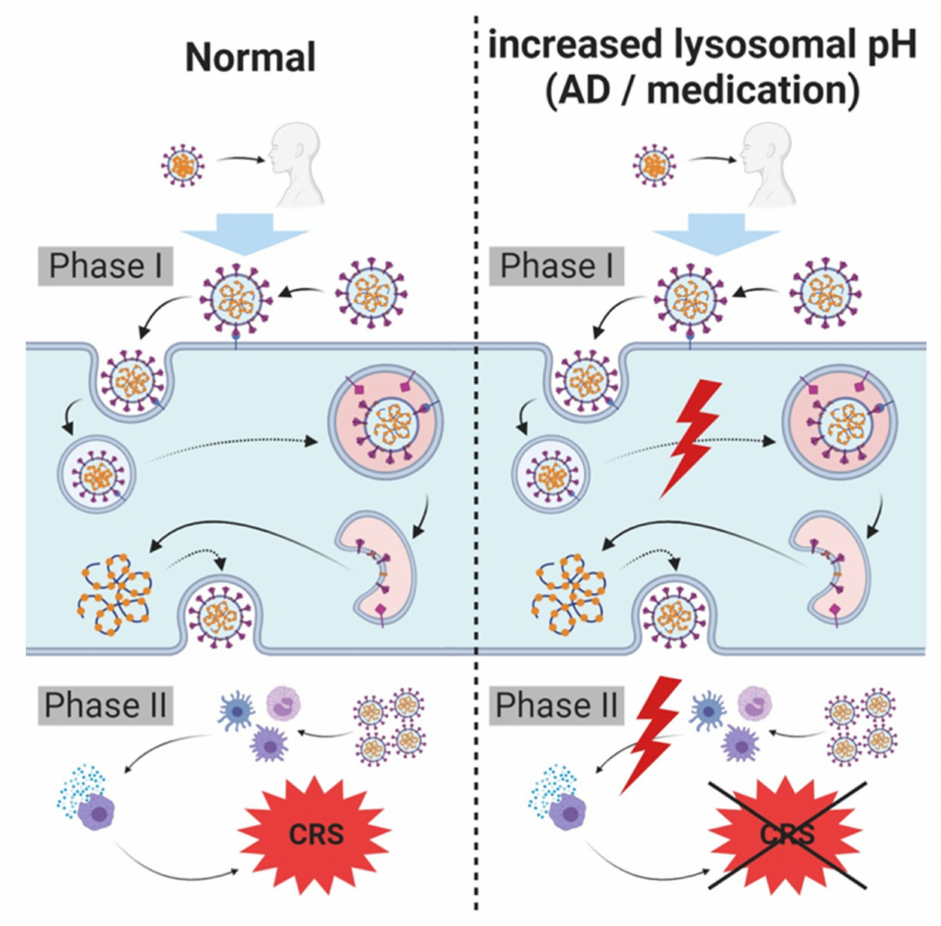
Figure 3. Hypothesis regarding lysosome related (skin) diseases, lysosomotropism, SARS-CoV-2 carriers, spreaders and non-infectable humans. SARS-CoV-2 infects host cells and triggers cytokine release requiring intact lysosomes. In case of an increased lysosomal pH, cellular entry and severe cytokine release (cytokine release syndrome (CRS) / cytokine storm) are inhibited, diminishing symptoms of infection and / or severity of COVID-19; complete prevention of infection is possible. An increased lysosomal pH in these individuals may either be the result of a breakdown of lysosomal proton pump (vacuolar H + ATPase (V-ATPase)), resulting from various disorders (e.g., atopic dermatitis (AD) or psoriasis vulgaris), or due to the administration of lysosomotropic compounds for other pre-existing